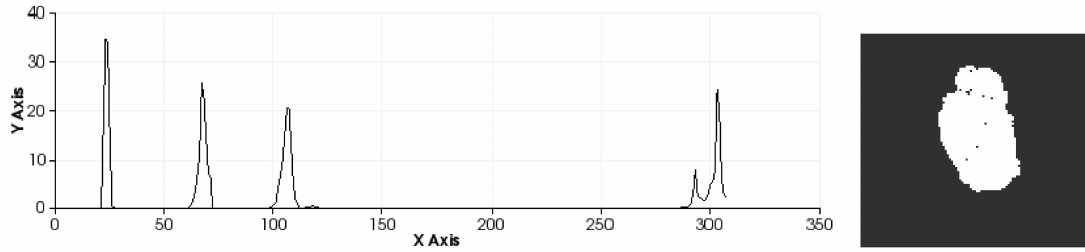
Figure 9. Sets of descriptors computed to recognise several left-hand gestures I. Descriptor in the left. Pose in the right.